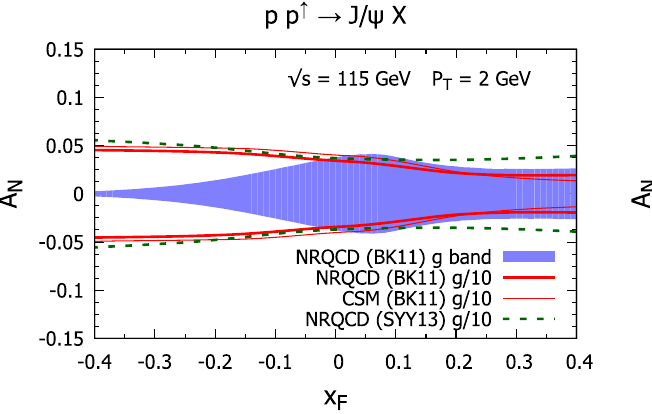
sets and in the CSM (thin red solid lines). All curves are rescaled by a factor of 10. The bands represent the predictions obtained by using the corresponding PHENIX data to constrain the GSF, within the NRQCD approach (BK11 LDME set). Notice that here negative rapidities cor- respond to the forward region for the polarized